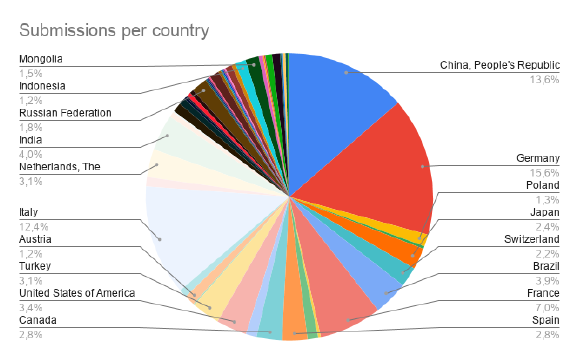
Figure 1. Submitted papers per country.